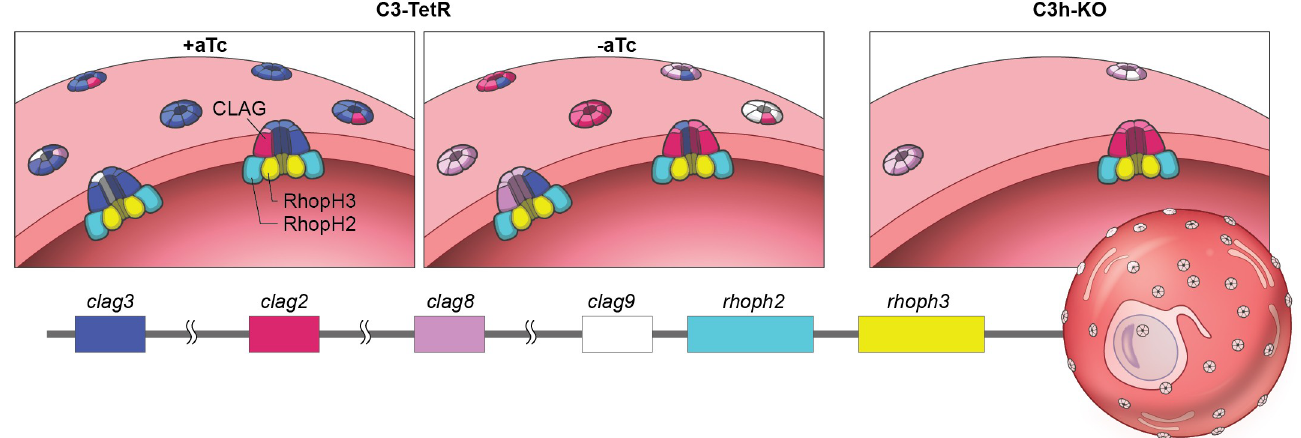
Fig 7. Proposed model for CLAG3 contribution to increased permeability of infected erythrocytes. Illustration shows the host erythrocyte membrane with channels composed of complexes that have several CLAG monomers in association with RhopH2 and RhopH3 proteins at their cytosolic face. Our model incorporates the observed 90% reduction of CLAG3 protein in C3-TetR when aTc is removed (middle vs. left panel), the 60–75% reduction in permeability in C3h-KO (right panel), and the greater transcription of clag3 genes than of other clags . We propose that ISPA-28 block of channels in the C3-TetR conditional knockdown is preserved because channel oligomers that contain at least one CLAG3 subunit retain sensitivity to this inhibitor; the precise stoichiometries of CLAG, RhopH2, and RhopH3 subunits and their relative positions within functional channels remain unknown. The C3h-KO knockout retains PSAC activity at a reduced level because other CLAG paralogs may oligomerize to form channels. Ribbon legend shows subunit color-coding with breaks to reflect expression from distinct